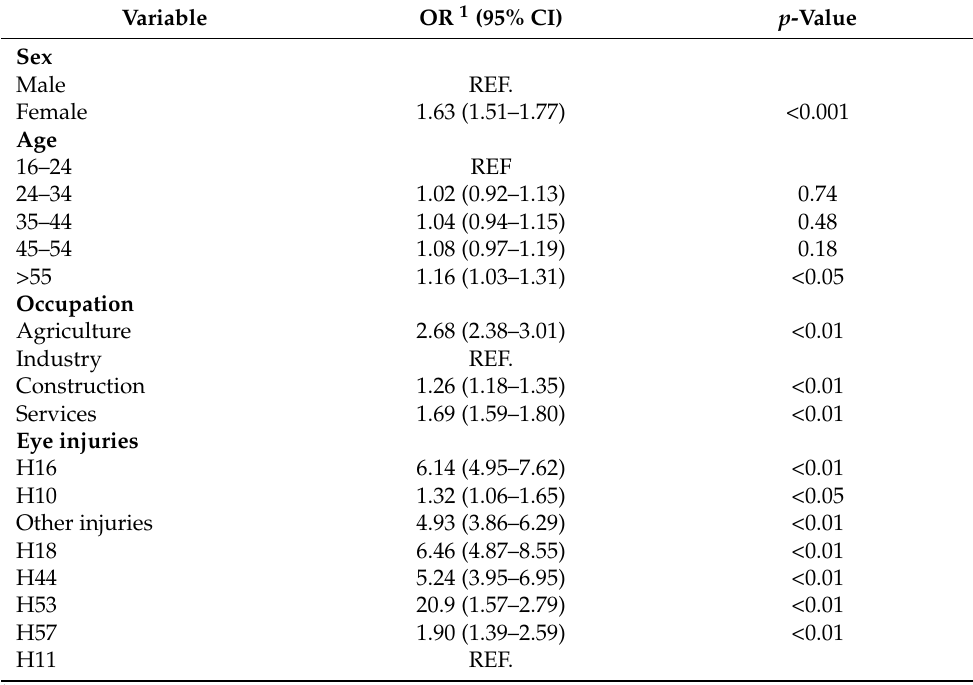
Table 1. Predictors of sick leave in workers who suffered a work-related eye